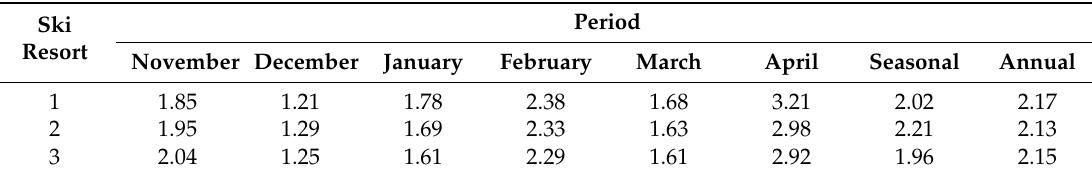
Table 1. Projected Temperature ( ˝ C) Changes at the Major Ski Resorts in Northeast Turkey from